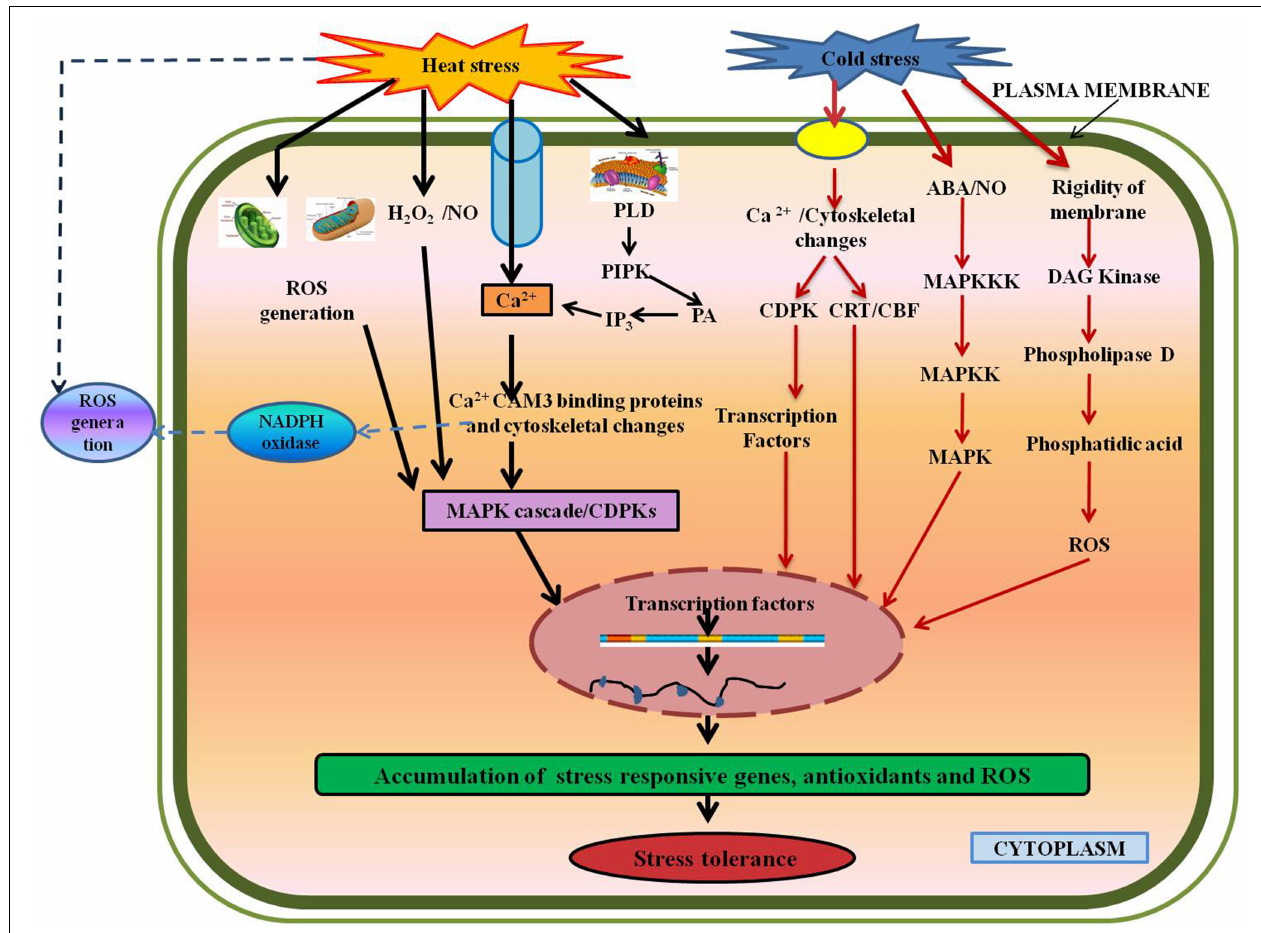
FIGURE 4 | Various signaling and defense pathways in response to temperature stresses. Temperature stresses affect the plasma membrane to activate calcium channels, which induces Ca 2 + influx (Saidi et al., 2009), thus the MAPK cascade leading to gene expression. Secondary signals like ROS, H 2 O 2 , NO, and ABA lead to stress-tolerance (Hua, 2009; Mishkind